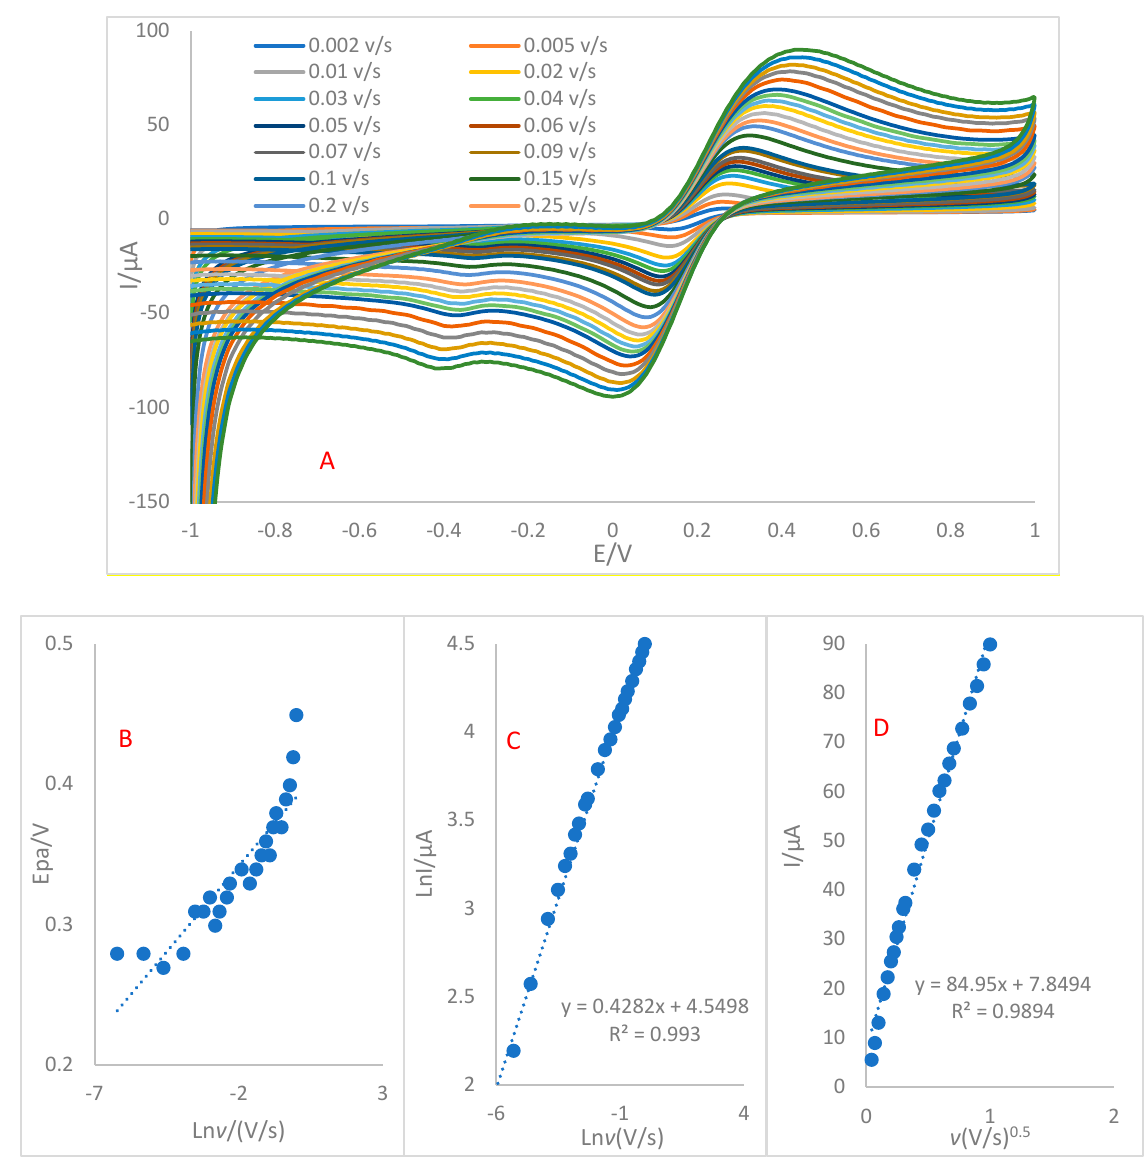
Figure 3. ( A ) CV of GCE-P( β -CD) at scan rates ranging from 0.002 to 1 V/s. ( B ) Dependence of the E pa vs. Ln v . ( C ) Dependence of LnI p vs. Ln v . ( D ) Dependence of Ip to the square root of sweep rates.